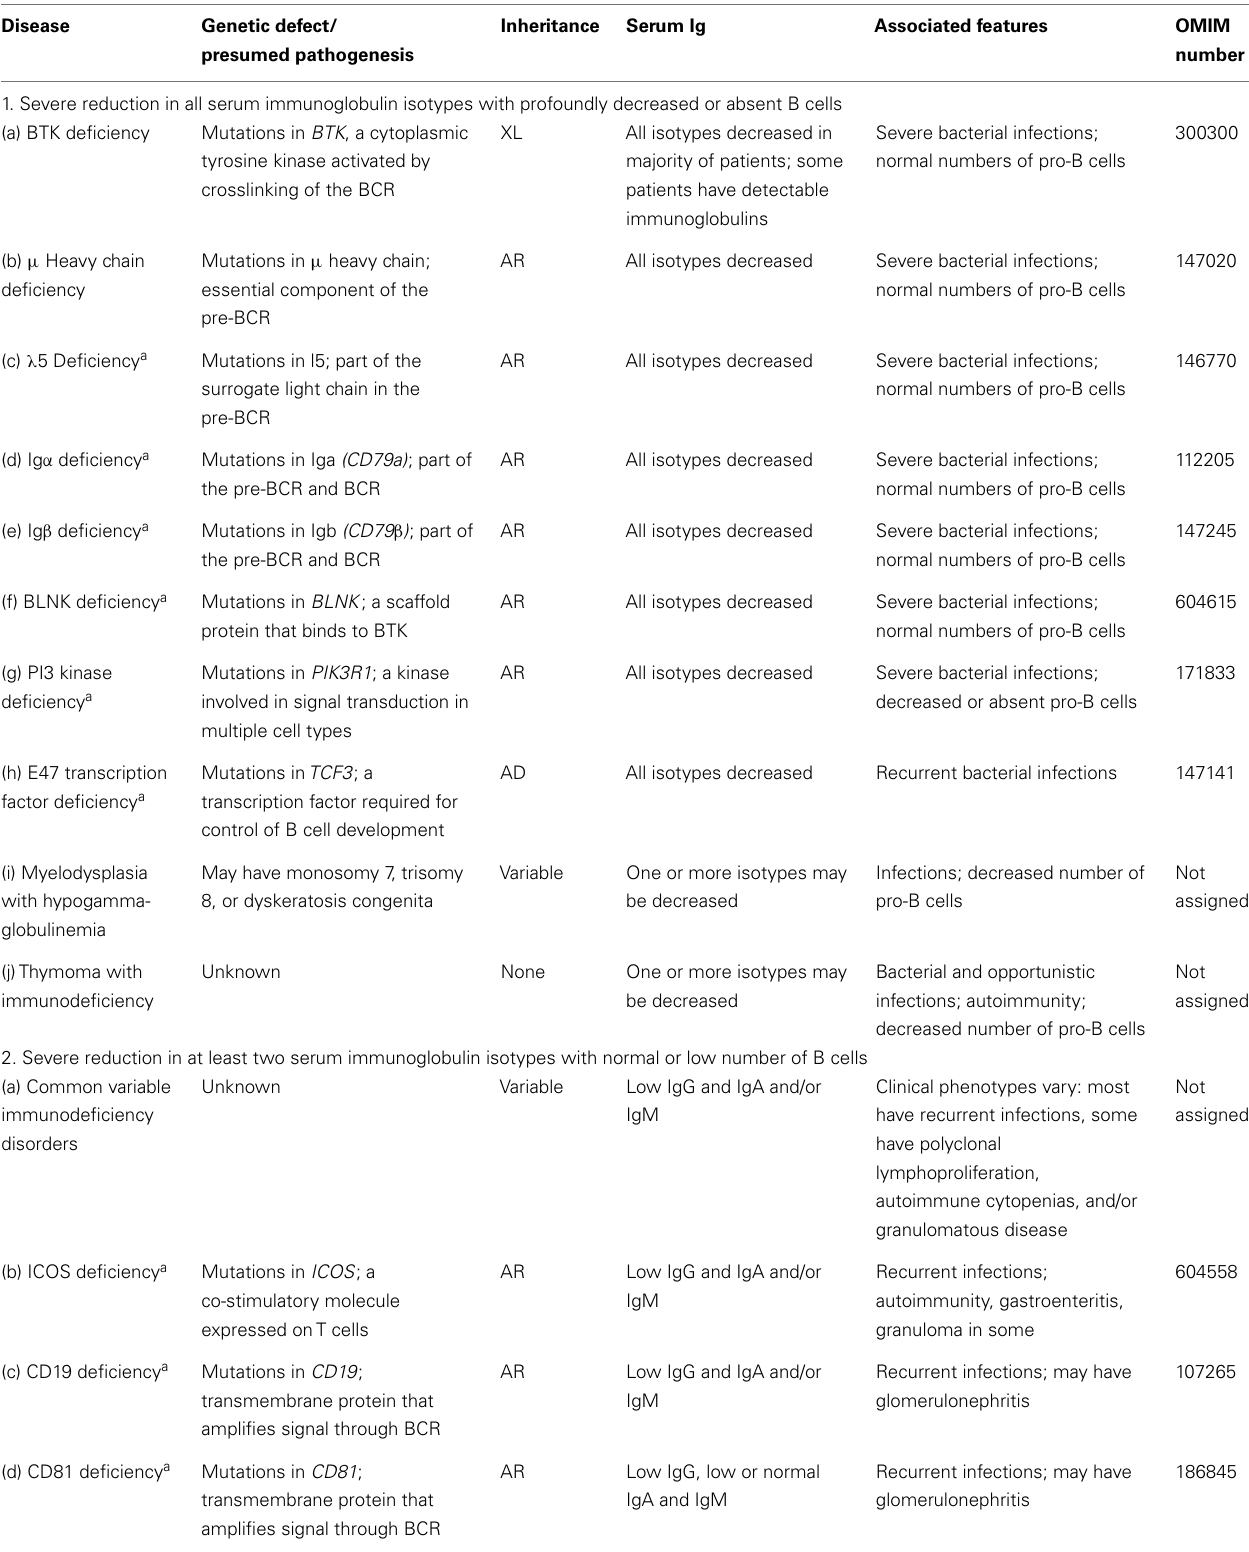
Table 3 | Predominantly antibody